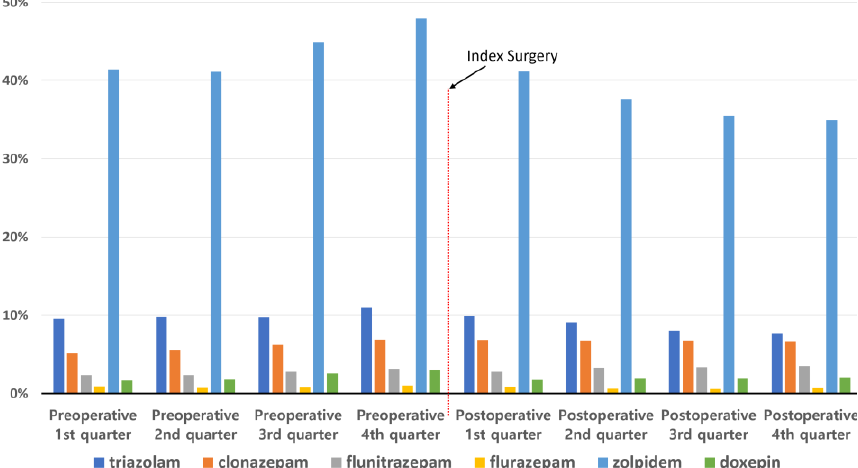
Figure 4. Types of sleep medication used during the perioperative